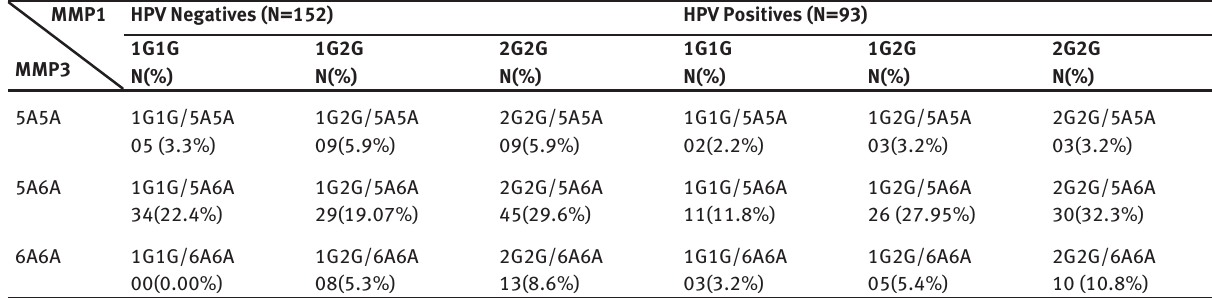
Table 6: The combined effect of polymorphisms of the MMP1 and MMP3 genes on the HR-HPV genotype.